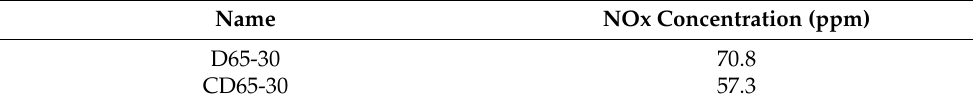
Table 4. Average NOx concentration at the furnace exit for D65-30,